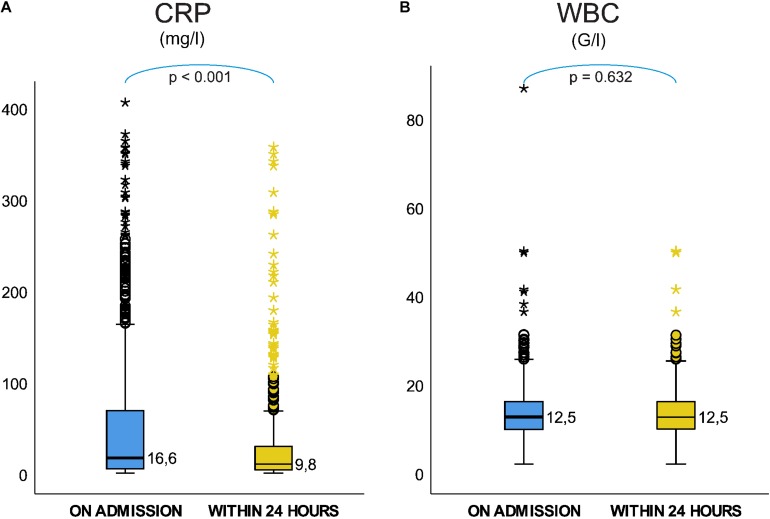
(A) Testing of homoscedasticity reveals a significant difference in the dispersion of CRP values limited to the 24 h from the onset of pain, compared to all on admission CRP values’ dispersions. (B) There is no difference in the dispersion of values of WBC.